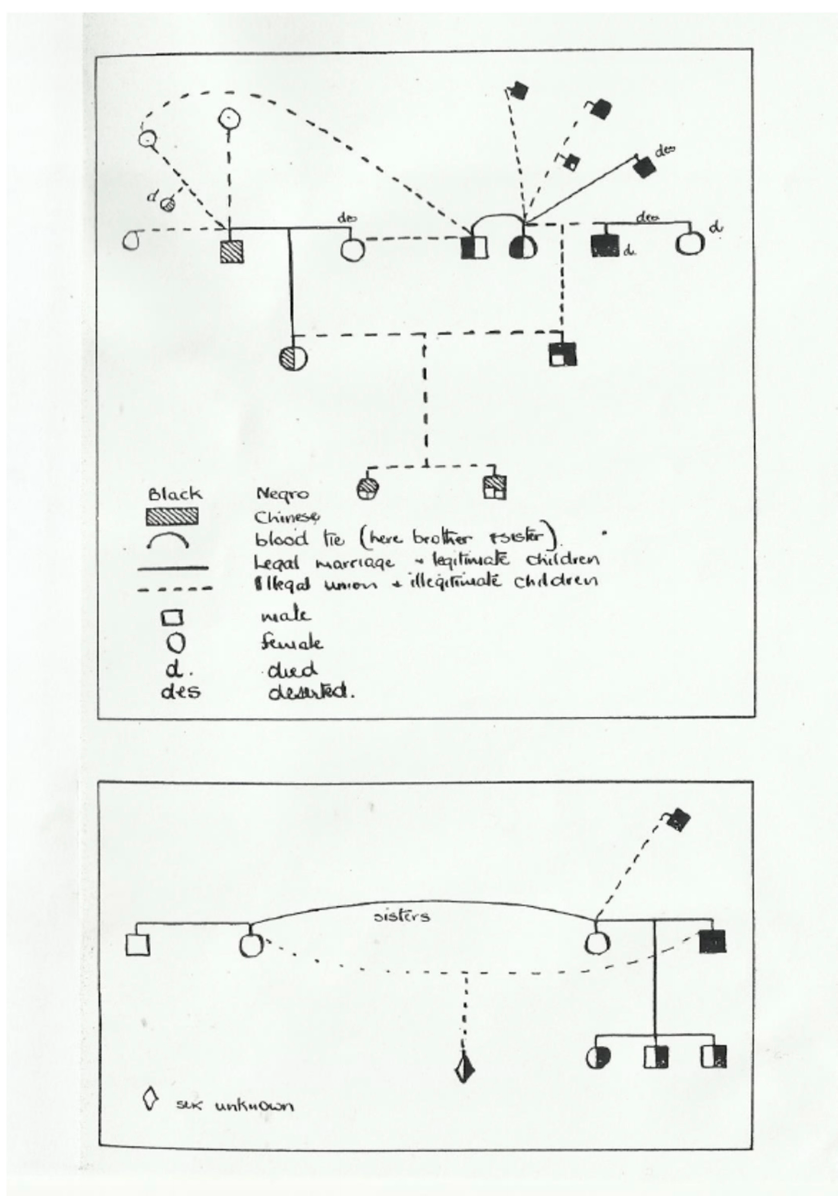
Figure 2. Genealogical trees illustrating ‘the instability of the family’. Source: From a set of four trees in M.E. Fletcher (Fletcher 1930).